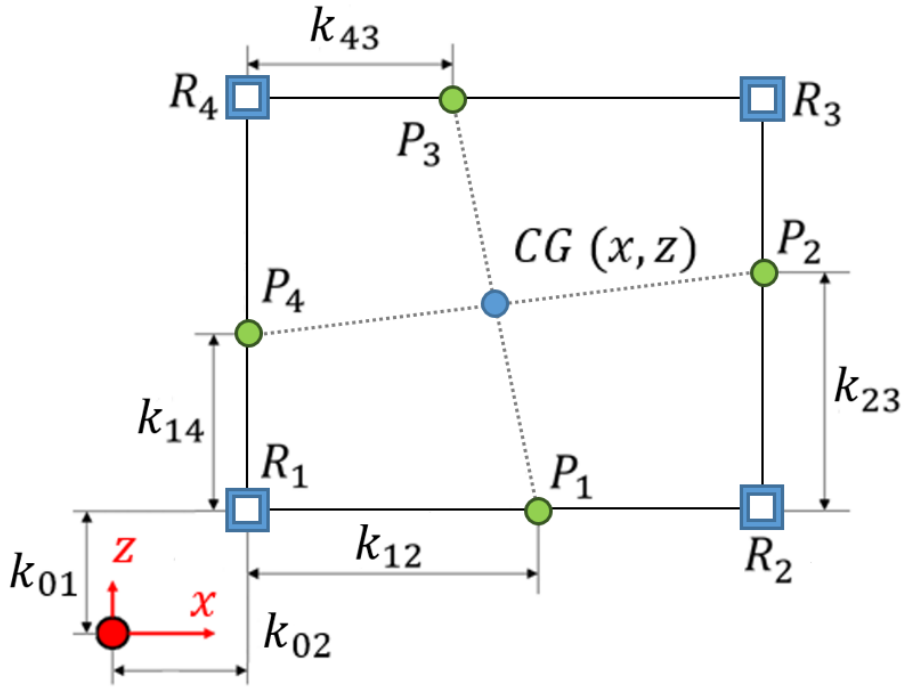
Figure 5. The scheme of the method for determining the location of the centre of gravity on the horizontal plane, the description of symbols is given in the text [43].